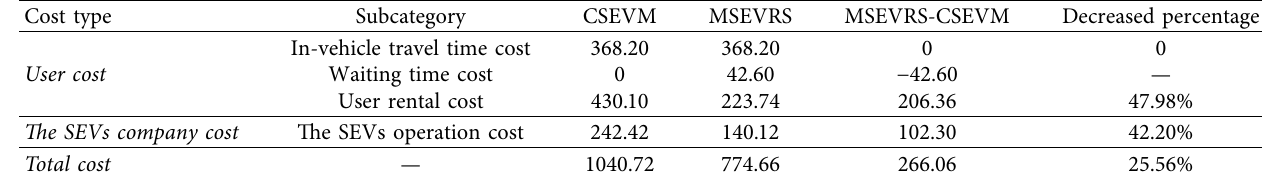
Table 5: The various costs in CSEVM and